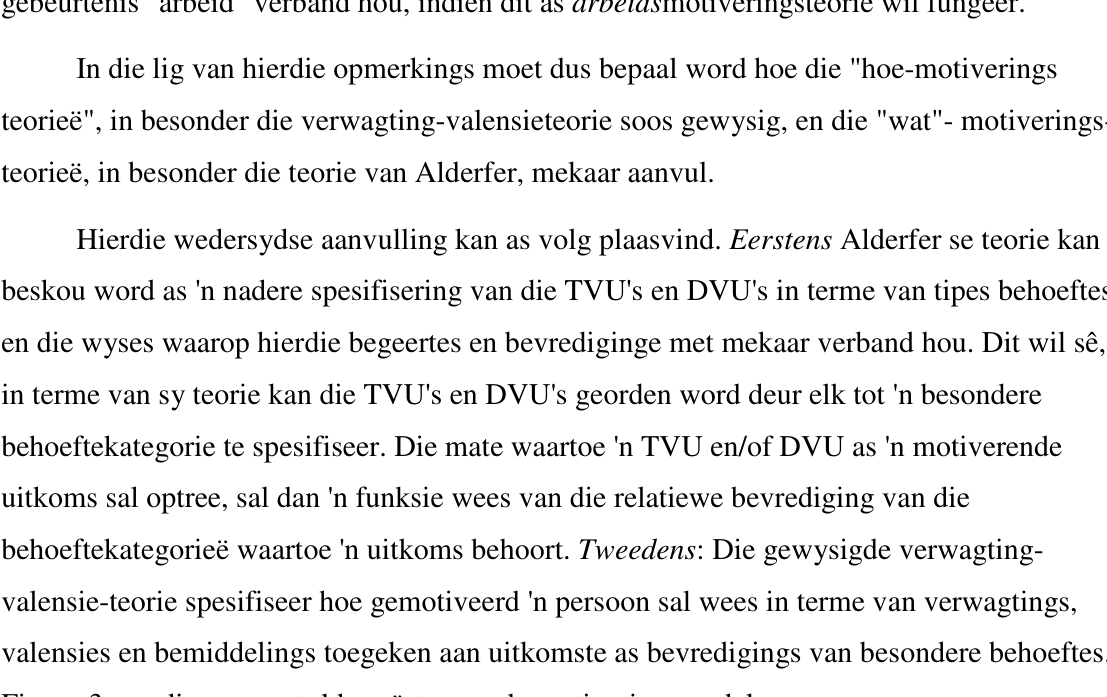
Figuur 3 gee die voorgestelde geïntegreerde motiveringsmodel weer. Die volgende opmerkings moet met betrekking tot Figuur 3 gemaak